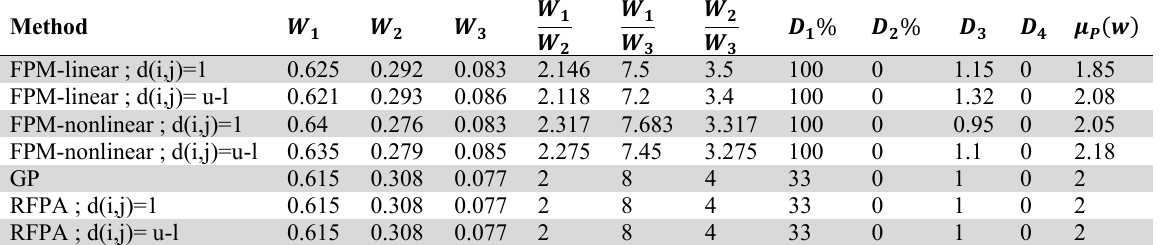
Three-dimensional weak inconsistent judgments Method